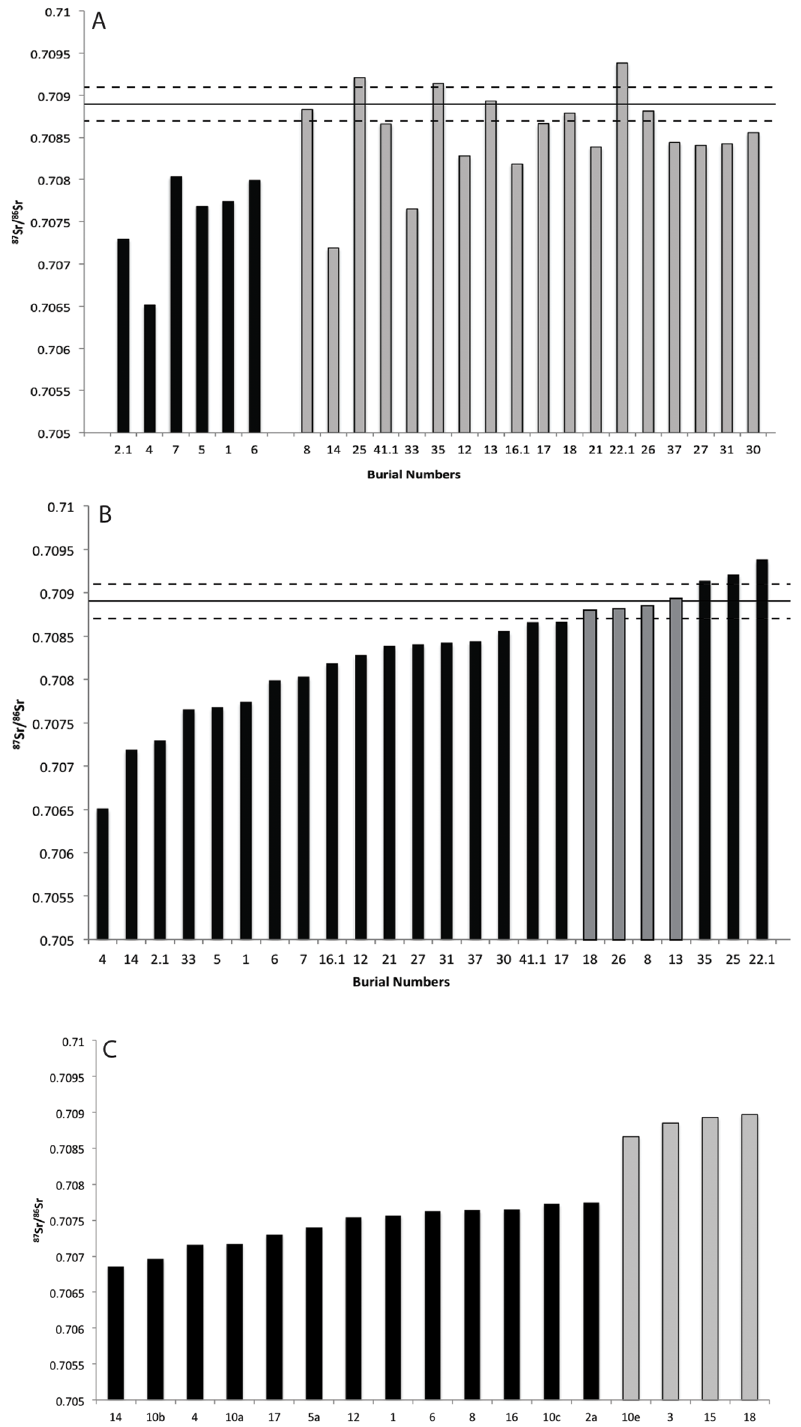
Fig 8. Strontium isotope data from Pacific Island samples. A — Reproduction of Kinaston et al. (2013, Fig 5) showing the strontium values of individuals within their Group 1 (black) and Group 2/3 (grey). B. Strontium values from Wairau Bar individuals organised into rank order, grey bars represent individuals within two standard deviations of the mean dog value. C — Strontium isotope data from Teouma, Vanuatu (Bentley et al. 2007). Grey bars represent individuals considered to be outliers or immigrants to the